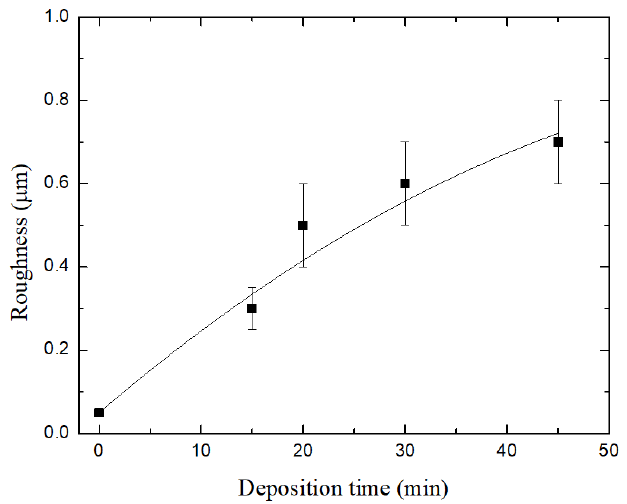
Figure 3. Roughness of the plasma polymerized carvacrol films as a function of deposition time. The value at t = 0 corresponds to the roughness of the substrate exposed to the monomer with the plasma o ff . Materials 2019 , 12 , x FOR PEER REVIEW 6 of 11